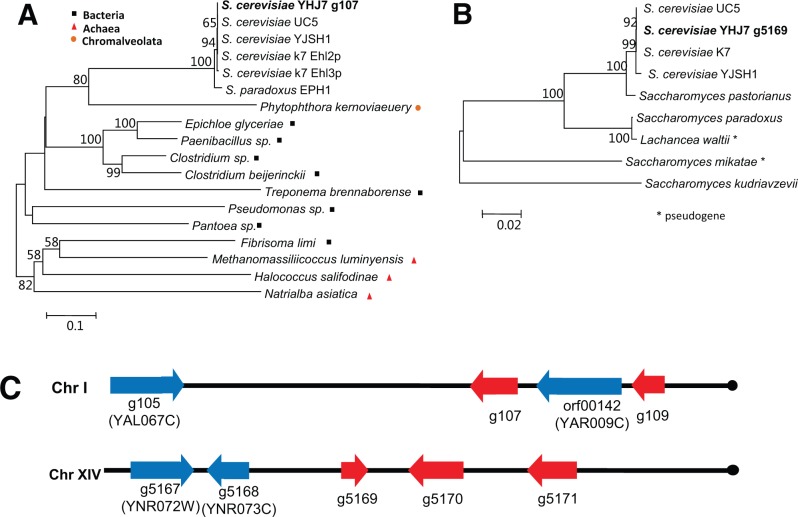
Origin and evolution of YHJ7 strain genes absent in S288c. (A) The YHJ7 g107 gene was likely originated from bacteria by horizontal gene transfer. (B) The homologous sequences of YHJ7 g5169 gene were found in several sake strains as well as other Saccharomyces sensu stricto species, but are absent in many S. cerevisiae strains. The lost of g5169 in S288c is probably due to the highly dynamic activity of subtelomeric region. The evolutionary history was inferred using the NJ method with 1,000 replicates of bootstrap test. The tree is drawn to scale. (C) YHJ7 strain-specific genes located in the subtelomeric regions of chromosomes. The arrows indicate the direction of transcriptions. Genes that are specific to YHJ7 relative to S288c were shaded in red. Genes with orthologous sequences in S288c were shaded in blue. The black dot indicates the end of a chromosome.